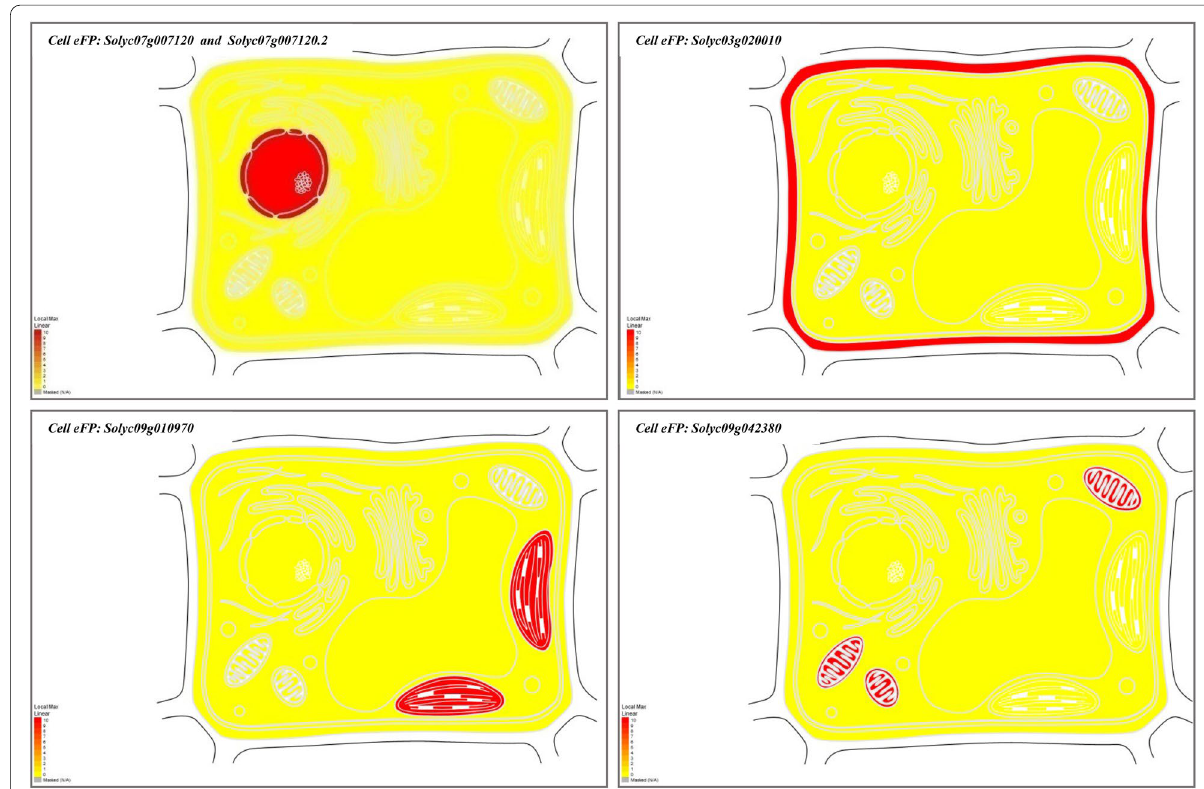
Fig. 6 Putative subcellular localizations of our genes based on tomato protein localization at different cell organs. Cell sub-cellular localizations profile images were built using cell electronic fluorescent pictograph browsers (cell eFP browsers). The bar represents the expression scale (the more intense red color, the more gene expression), http:// bar. utoro nto. ca/ eplant_